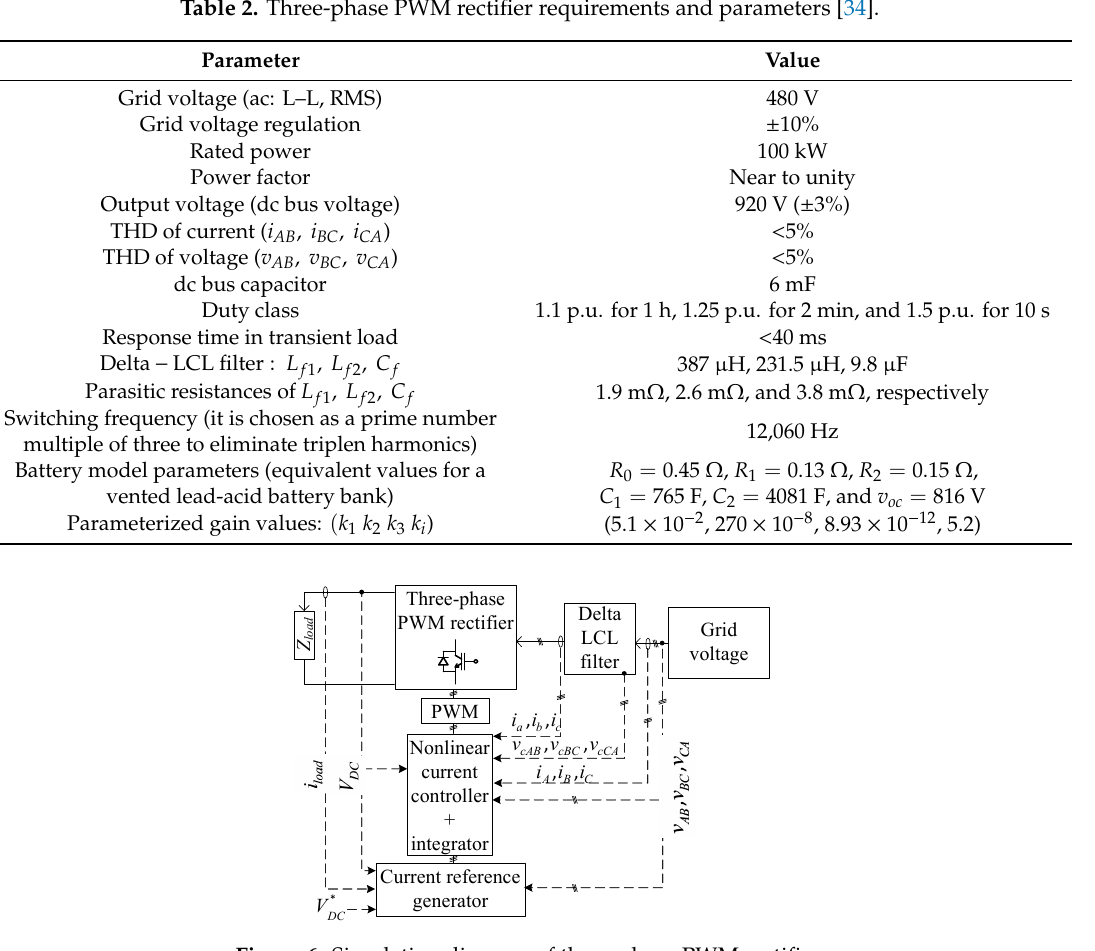
Figure 6. Simulation diagram of three-phase PWM rectifier.